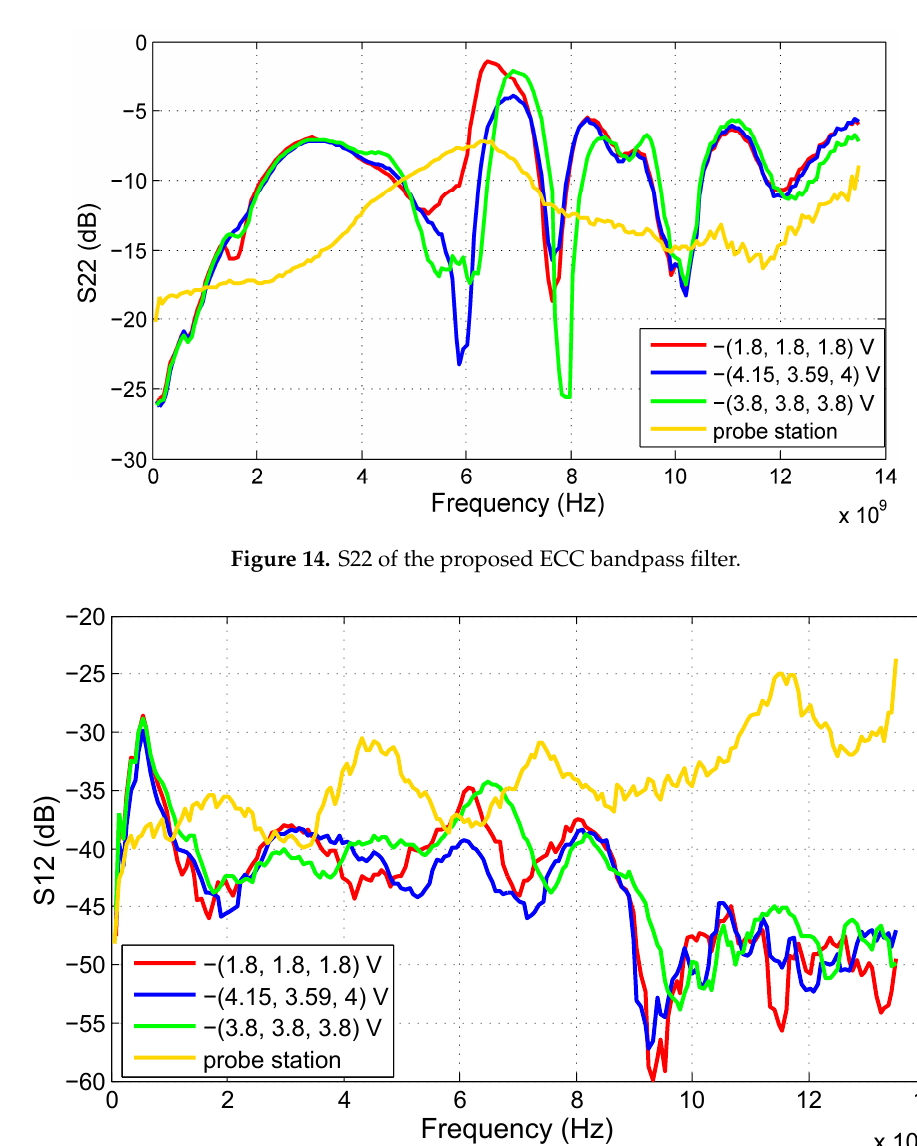
Figure 13. S11 of the proposed ECC bandpass filter.